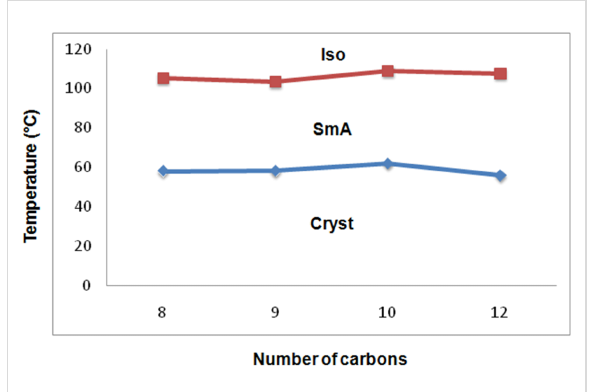
Figure 5: Phase diagram of the 13a (Ph.Ox.C*C n ) series.